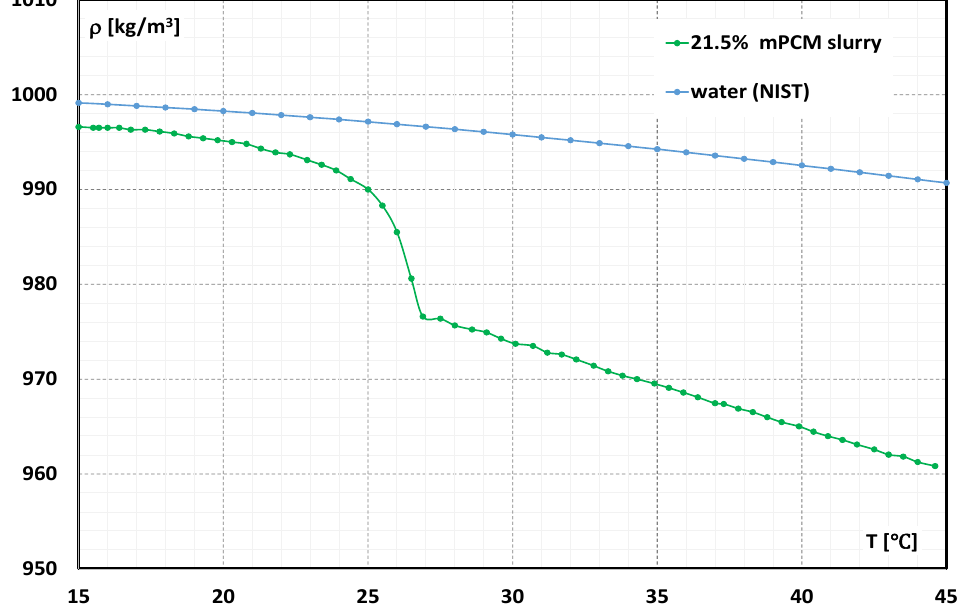
Figure 1. The dependence of slurry density (21.5% MPCM) on temperature.